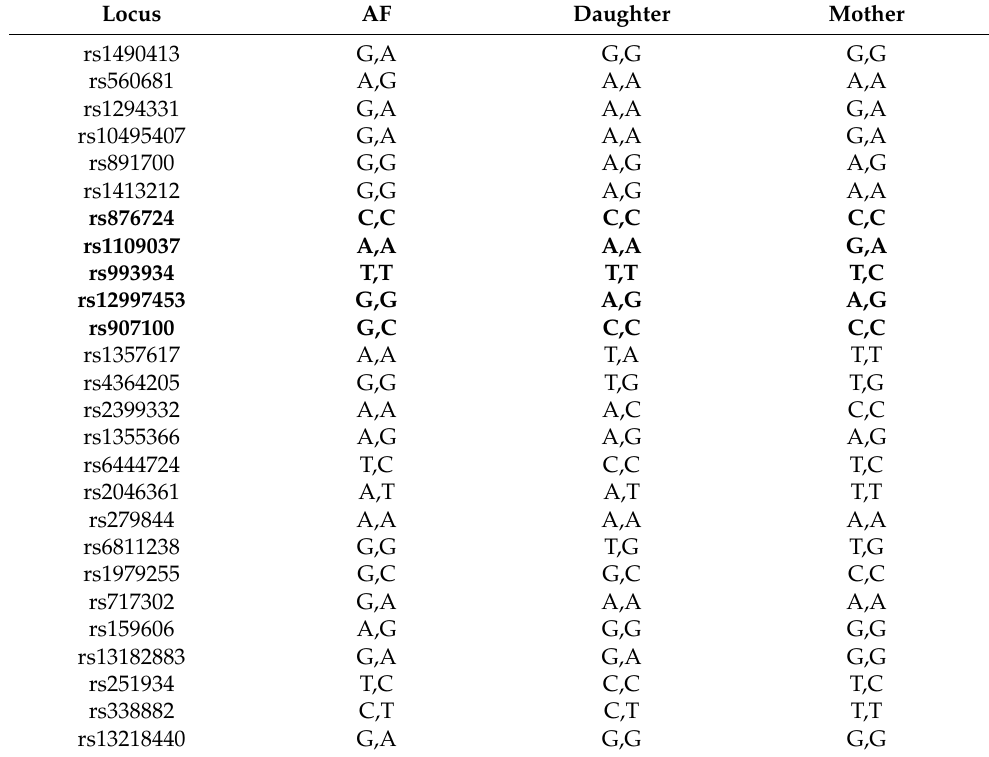
Table A2. Summary of single nucleotide polymorphism (SNP) genotypes obtained using Illumina MiSeq FGx Forensic Genomics System NGS (AF—alleged father). Five bolded loci are located at chromosome